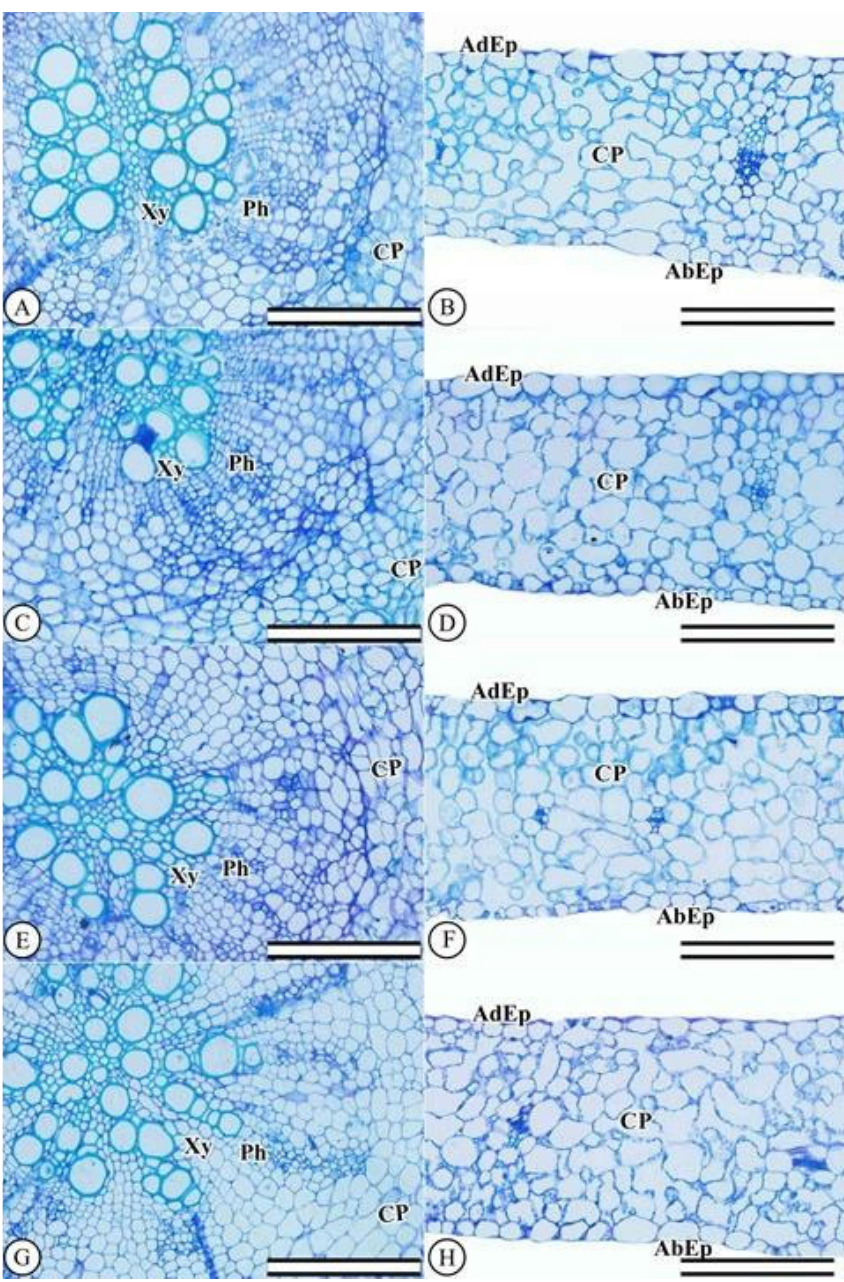
Figure 2. Root and leaf anatomy of Lactuca sativa L. plants following 40 days of exposure to potassium fluoride (KF) at different concentrations. ( A , B ) control (0 mg L − 1 ), ( C , D ) 10 mg L − 1 KF, ( E , F ) 20 mg L − 1 KF, and ( G,H ) 30 mg L − 1 KF. (EpAd) adaxial epidermis; (EpAb) abaxial epidermis; (CP) chlorophyll parenchyma; (Xy) xylem; (Ph) phloem. scale bar = 200 μ m.